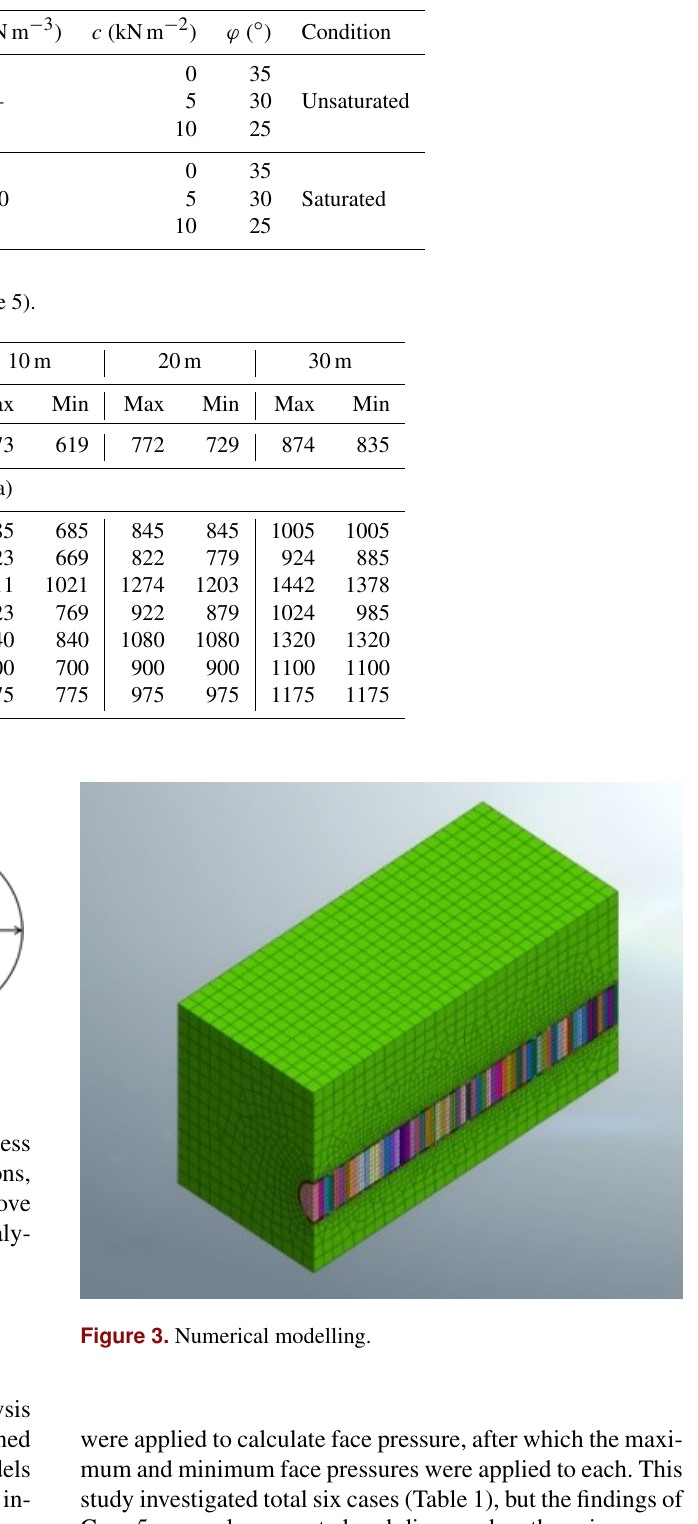
were applied to calculate face pressure, after which the maxi- mum and minimum face pressures were applied to each. This study investigated total six cases (Table 1), but the findings of Case 5 was only presented and discussed as the prime